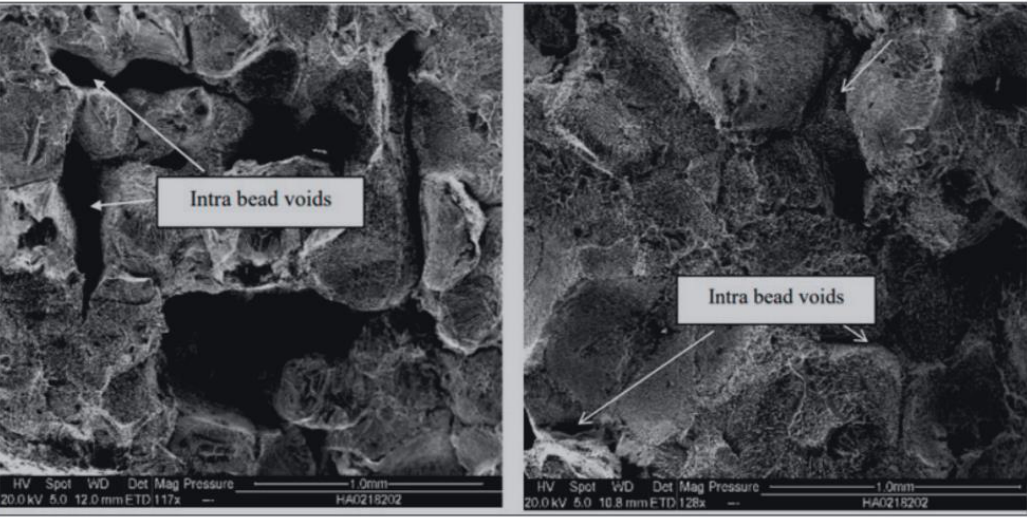
Figure 1. SEM image of LCMME-fabricated copper part [9] .